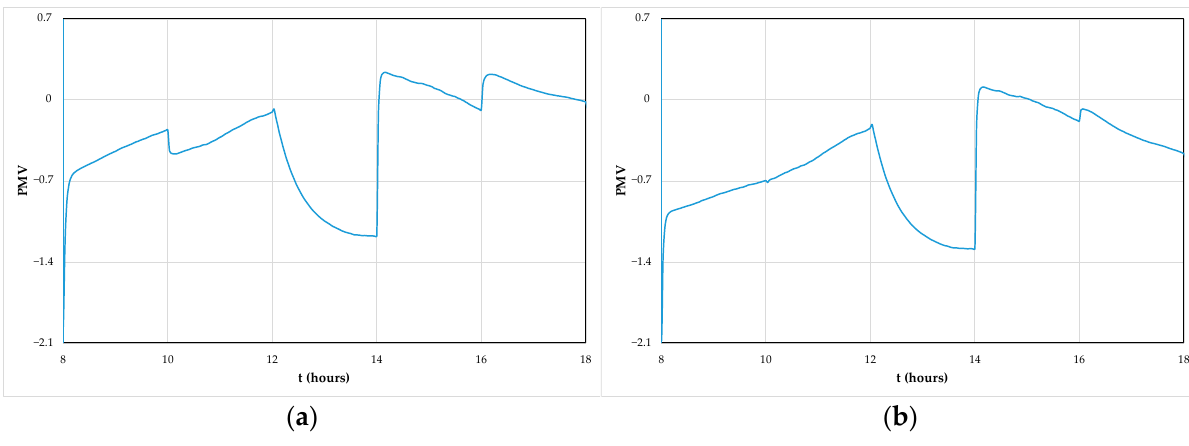
Figure 28. Evaluation of predicted mean vote (PMV) index for the Case I ( a ) and Case J ( b ).